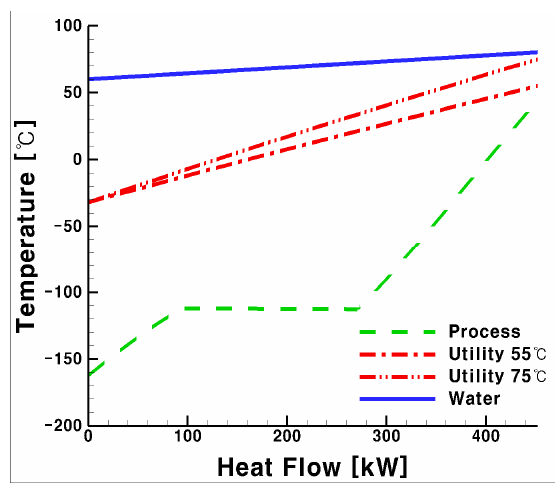
Figure 6. Heat transfer performance based on the temperature in each group when using glycol water.